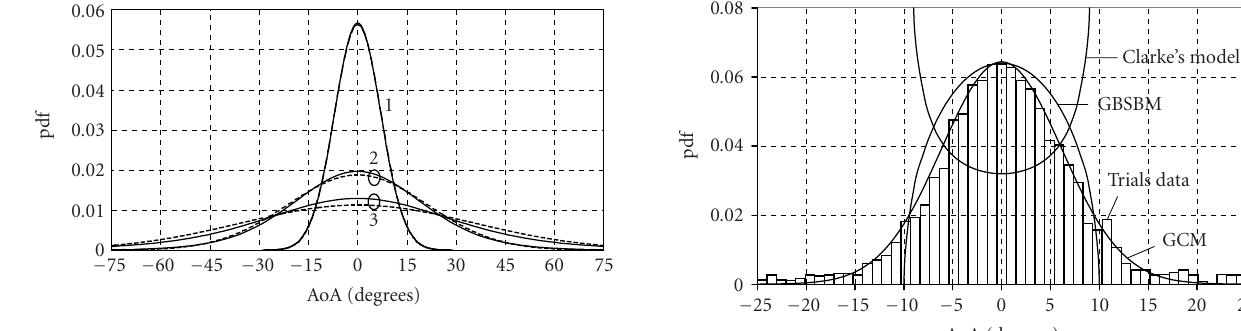
Figure 2: The pdf of the AoA of the multipaths at the BS. The angle spread is equal to 20, 60, and 100 degrees (curves 1, 2, 3, respec- tively). The solid and dashed curves correspond to the exact formula (8) and its Gaussian approximation (9), respectively.